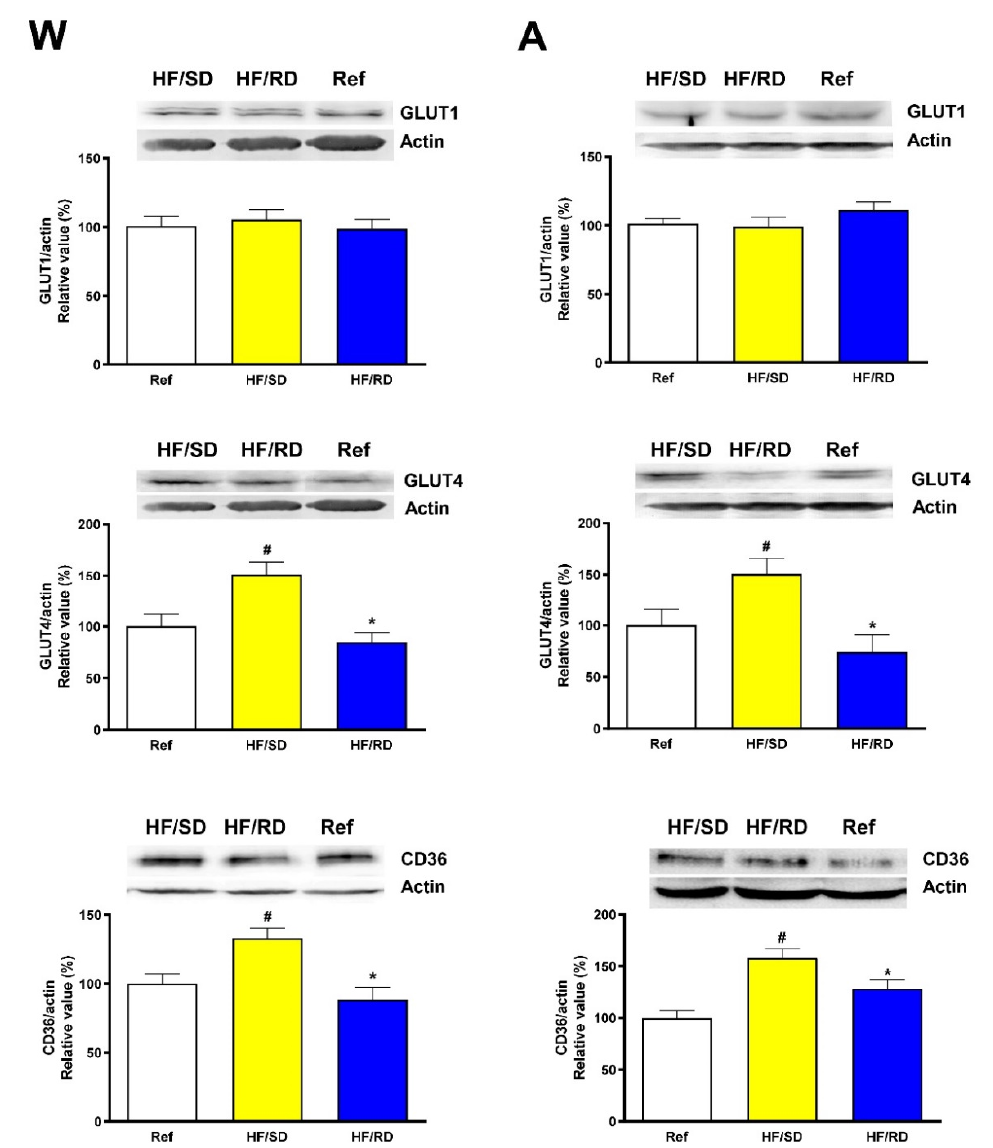
Figure 3. Fuel transporters expression in the o ff spring muscle. GLUT1, GLUT4 and FAT / CD36 transporters expression was assayed by Western blot in gastrocnemius muscle at weaning ( W ) and adolescence ( A ). Values are means ± SEM ( n = 8 for each experimental group). HF / SD: o ff spring from mothers on high-fat diet containing slow digesting carbohydrates; HF / RD: o ff spring from mothers on high-fat diet containing rapid digesting carbohydrates; Ref: o ff spring from mothers on AIN93G diet. * Significant di ff erence with HF / SD group, p < 0.05. # Significant di ff erence with reference group, p <